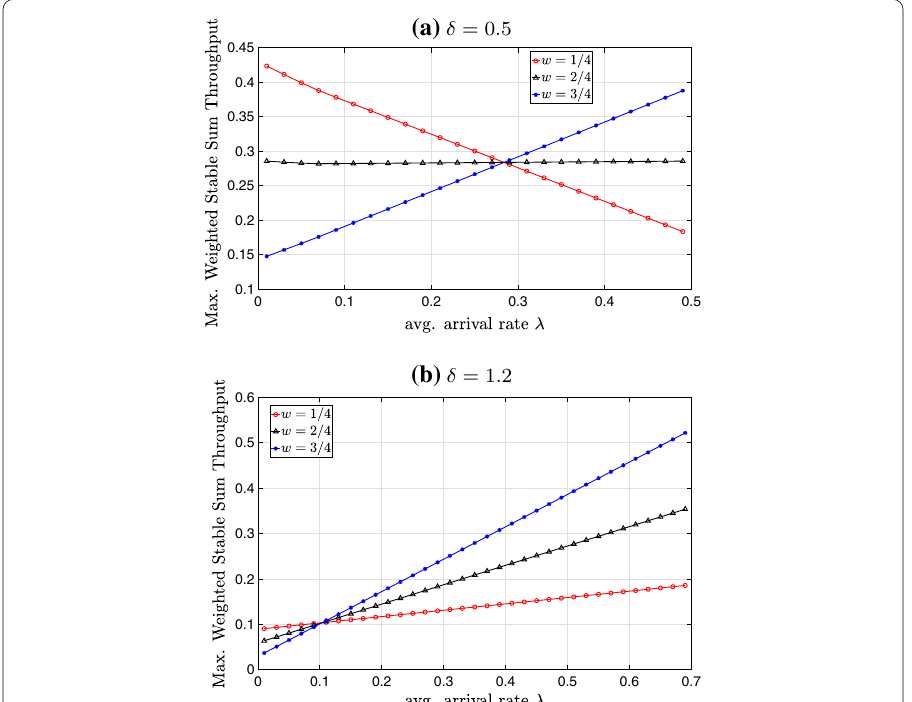
Fig. 5 The maximum weighted sum throughput vs. (cid:31) for α = 0.7 and different values of w when the queue at S is stable for: a δ = 0.5 and b δ = 1.2